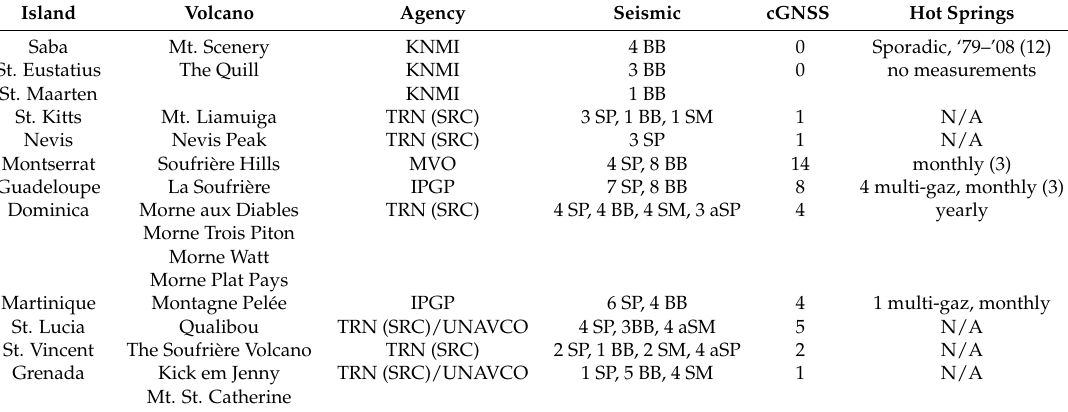
Table 1. Operational volcano monitoring equipment according to the responsible agencies